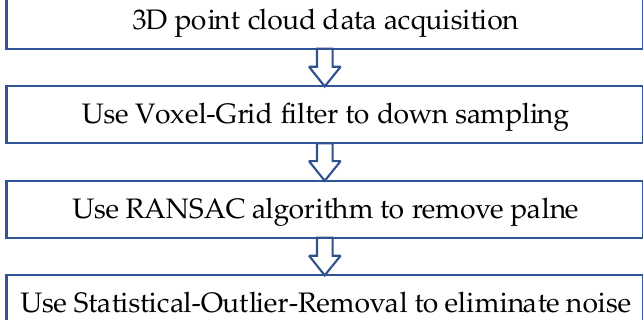
Figure 2. The process of data acquisition and preprocessing.